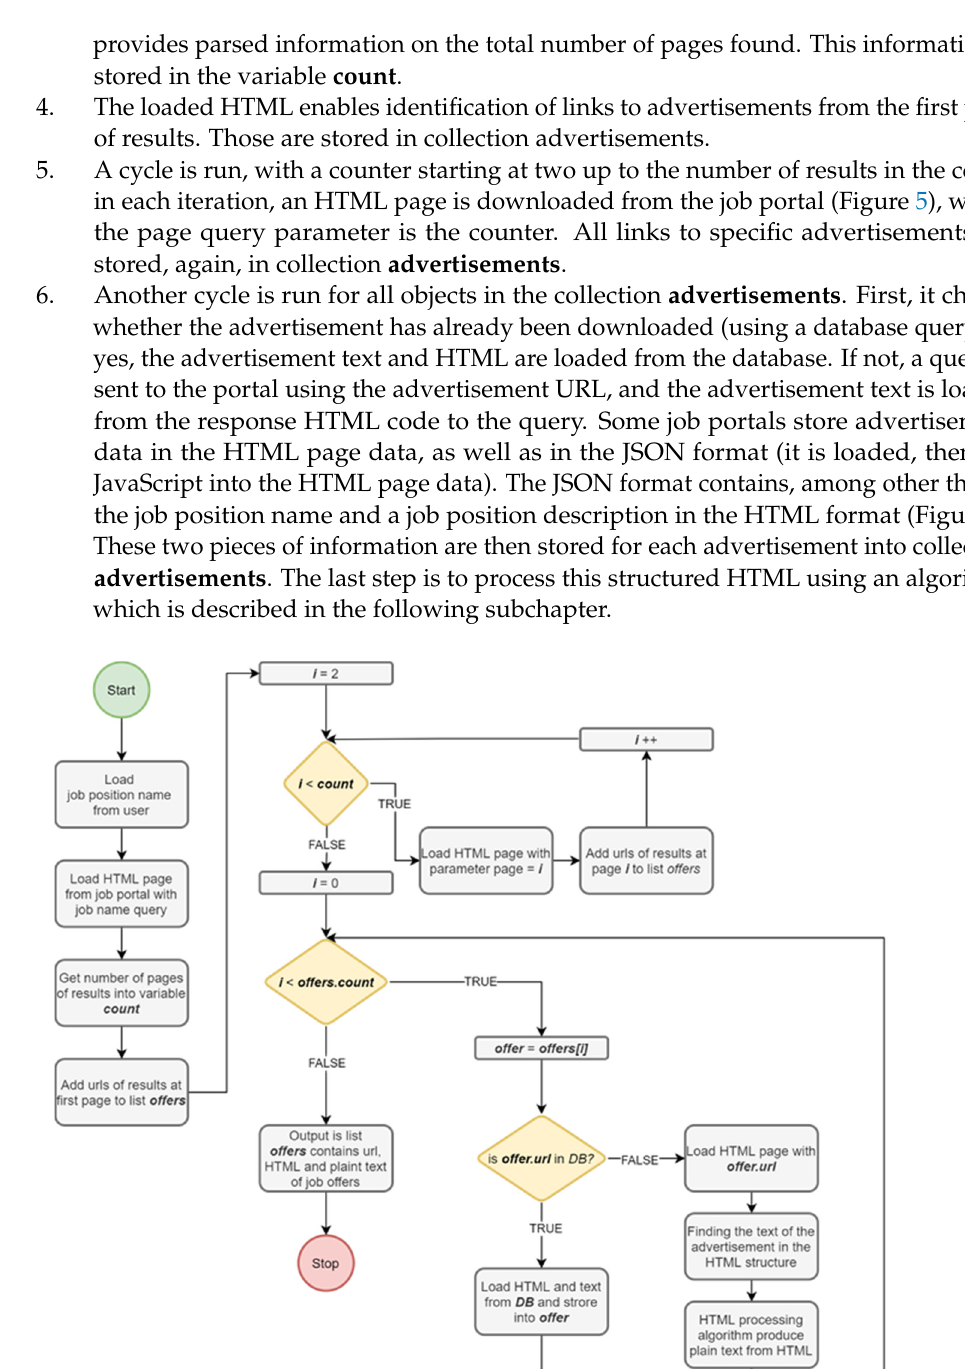
Figure 4. Example of search results using a search engine on a job portal www.dice.com (20 March 2021).